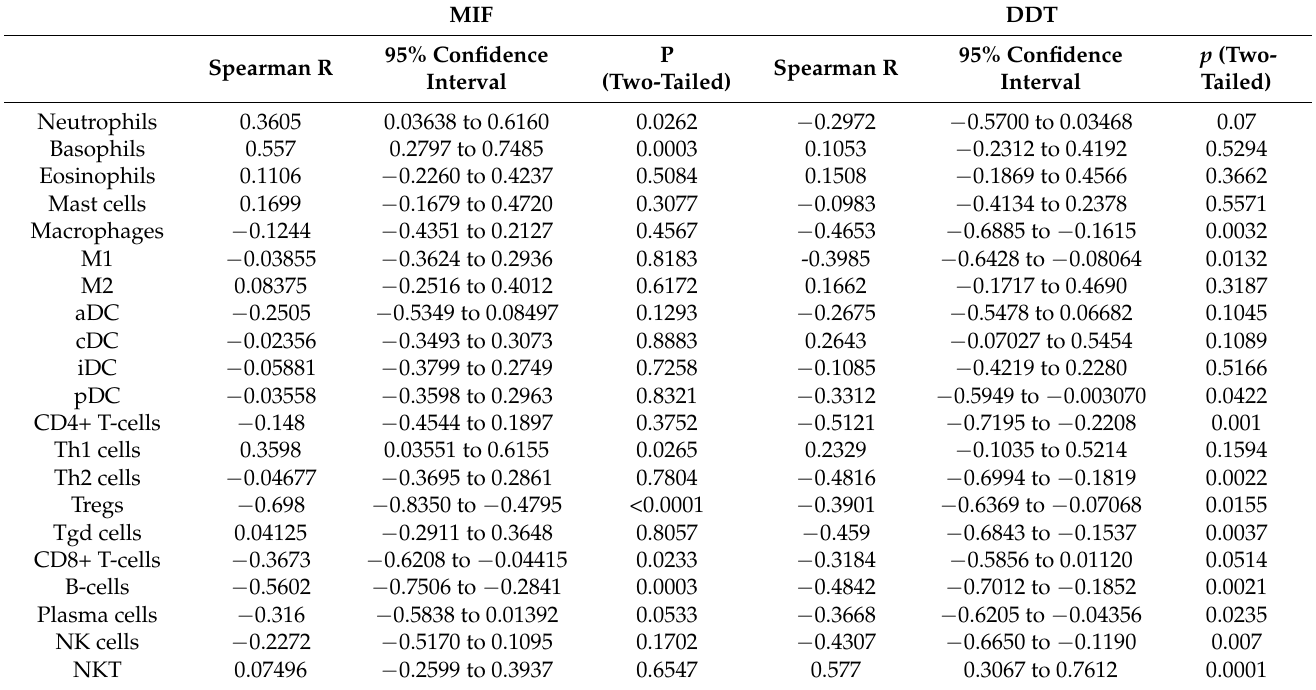
Table 3. Correlation between MIF and DDT and infiltrating immune cells in